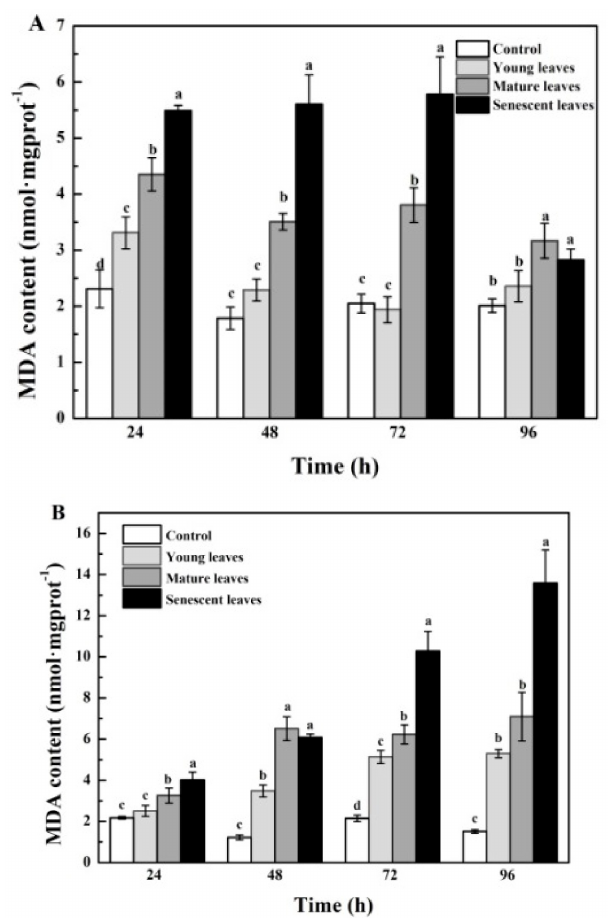
Figure 3. Malondialdehyde (MDA) content in P. globosa following treatment with mangrove leaf aqueous extracts of different leaf ages: ( A ) B. gymnorrhiza and ( B ) K. candel . The data are expressed as the mean ± standard error of the mean; n = 3 in each group. Values with different letters differ significantly from each other in the same time ( p <